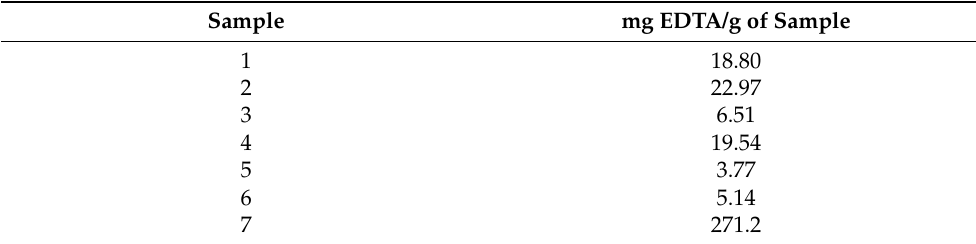
Table 18. Results expressed in mg EDTA/g of sample (ferroion chelation method with